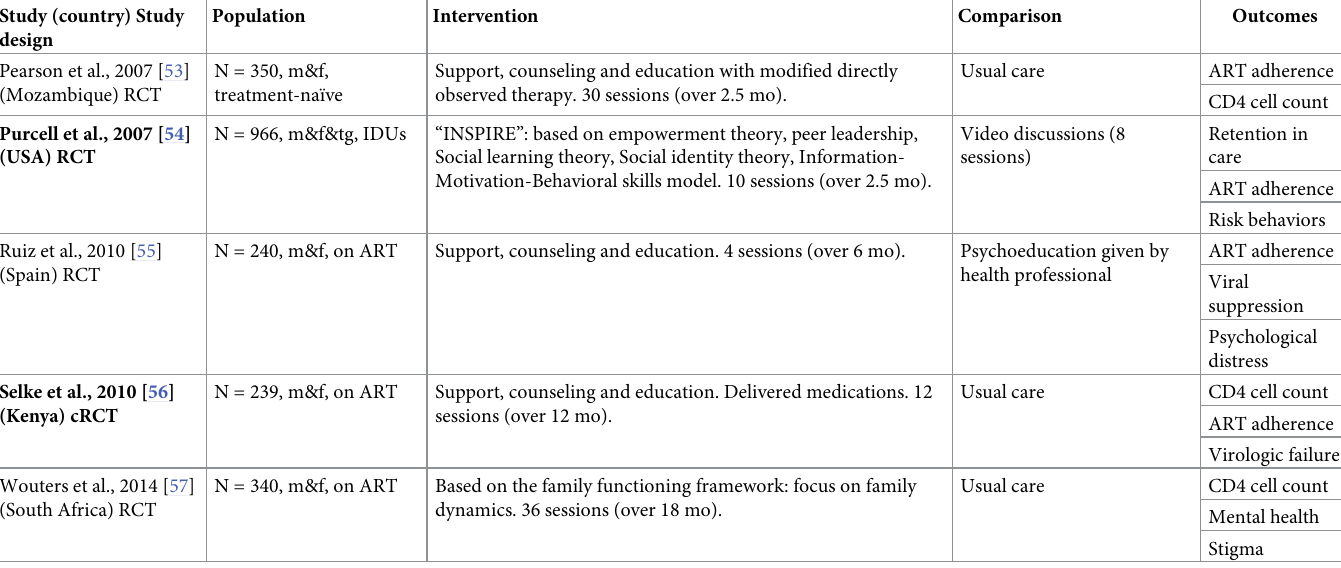
participants were retained in care at both 6-months follow-up and 12-months follow-up (Fig 3. RR = 1.05, 95% CI = 0.92, 1.20; RR = 1.07, 95% CI = 1.02, 1.12, respectively). While